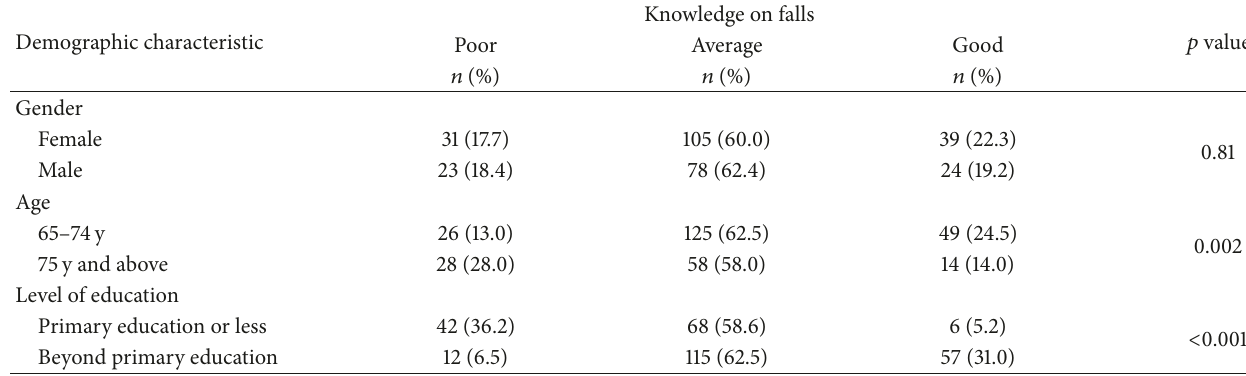
Table 3: Association of knowledge of falls with demographic characteristics ( 𝑛 = 300 ).